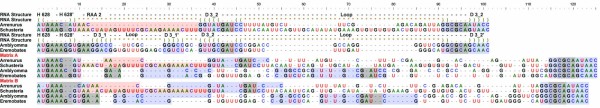
Sensitivity of homology assessment to the morphological matrices. Sequences from the D3 region ranging from helix H628 to D3_2 of two Acariformes mites (Arrenurus and Schusteria), Anactinotrichda (Amblyoma) and Solifugae (Eremobates). A- Partially aligned sequences, with regions aligned according to the secondary structure shaded blue. Parenthesis indicates pairing sites, dots unpaired sites and (*) indicates regions considered unaligned. Note that D3_1 is absent in Acariformes. B- Implied alignment bound to the best trees of the unconstrained analysis of molecular data combined with matrix A, under cost regime 1:1:1. C- Implied alignment, under the same cost regime, analysis combined with the matrix B.